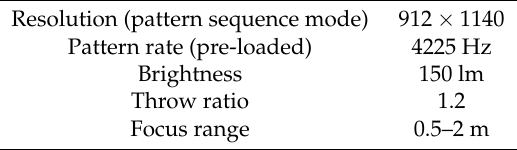
Table 1. Specifications of